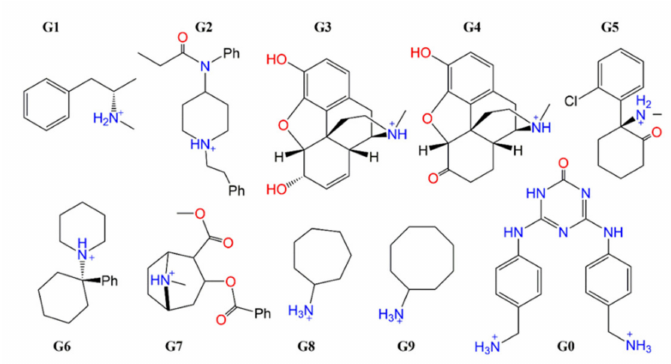
Figure 2. Structures of the guest molecules ( G0 – G9 ) used for calculations of Gibbs free energies of binding to the host